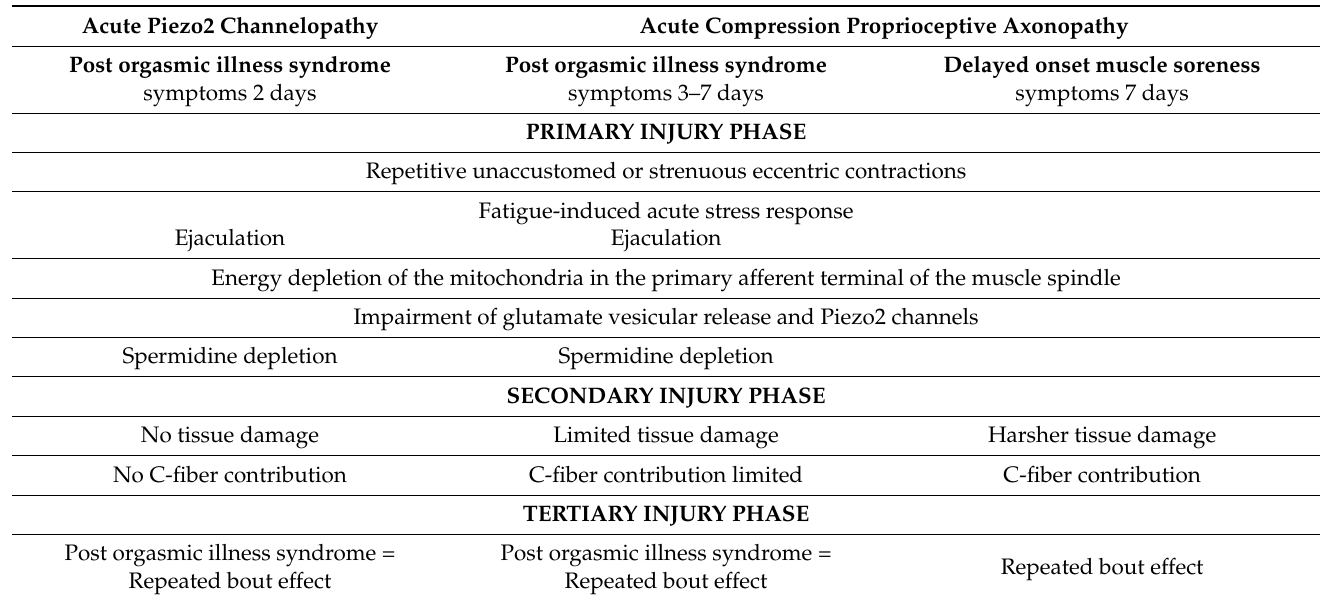
Table 1. The theoretical injury phases of POIS and